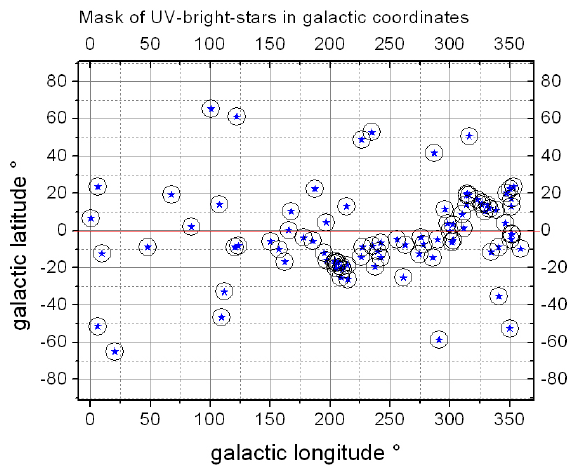
Figure 3. All-sky stellar exclusion map of 90 UV-bright stars based on a list published by Snow et al. (2013). All stars are masked with an 8 ◦ circle for LOS